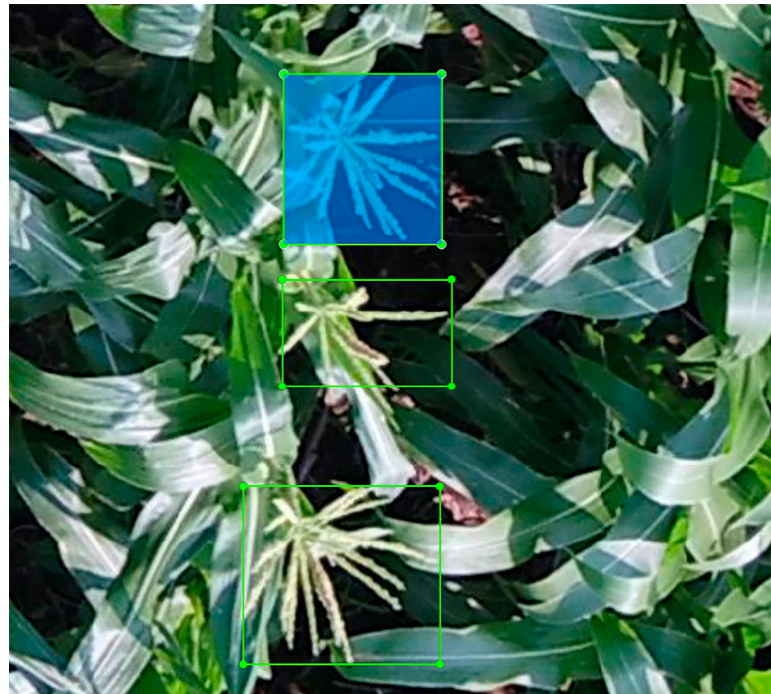
Figure 2. Bounding boxes of maize tassels interactively drawn using the LabelImg software.